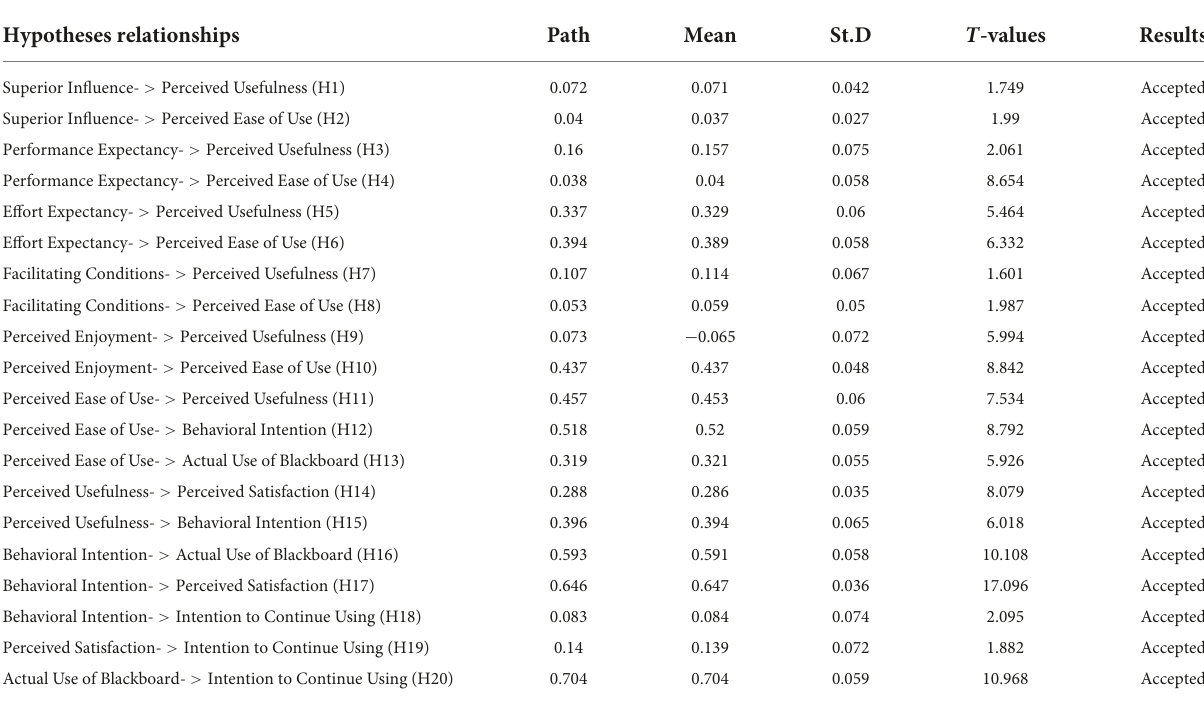
TABLE 5 Hypotheses